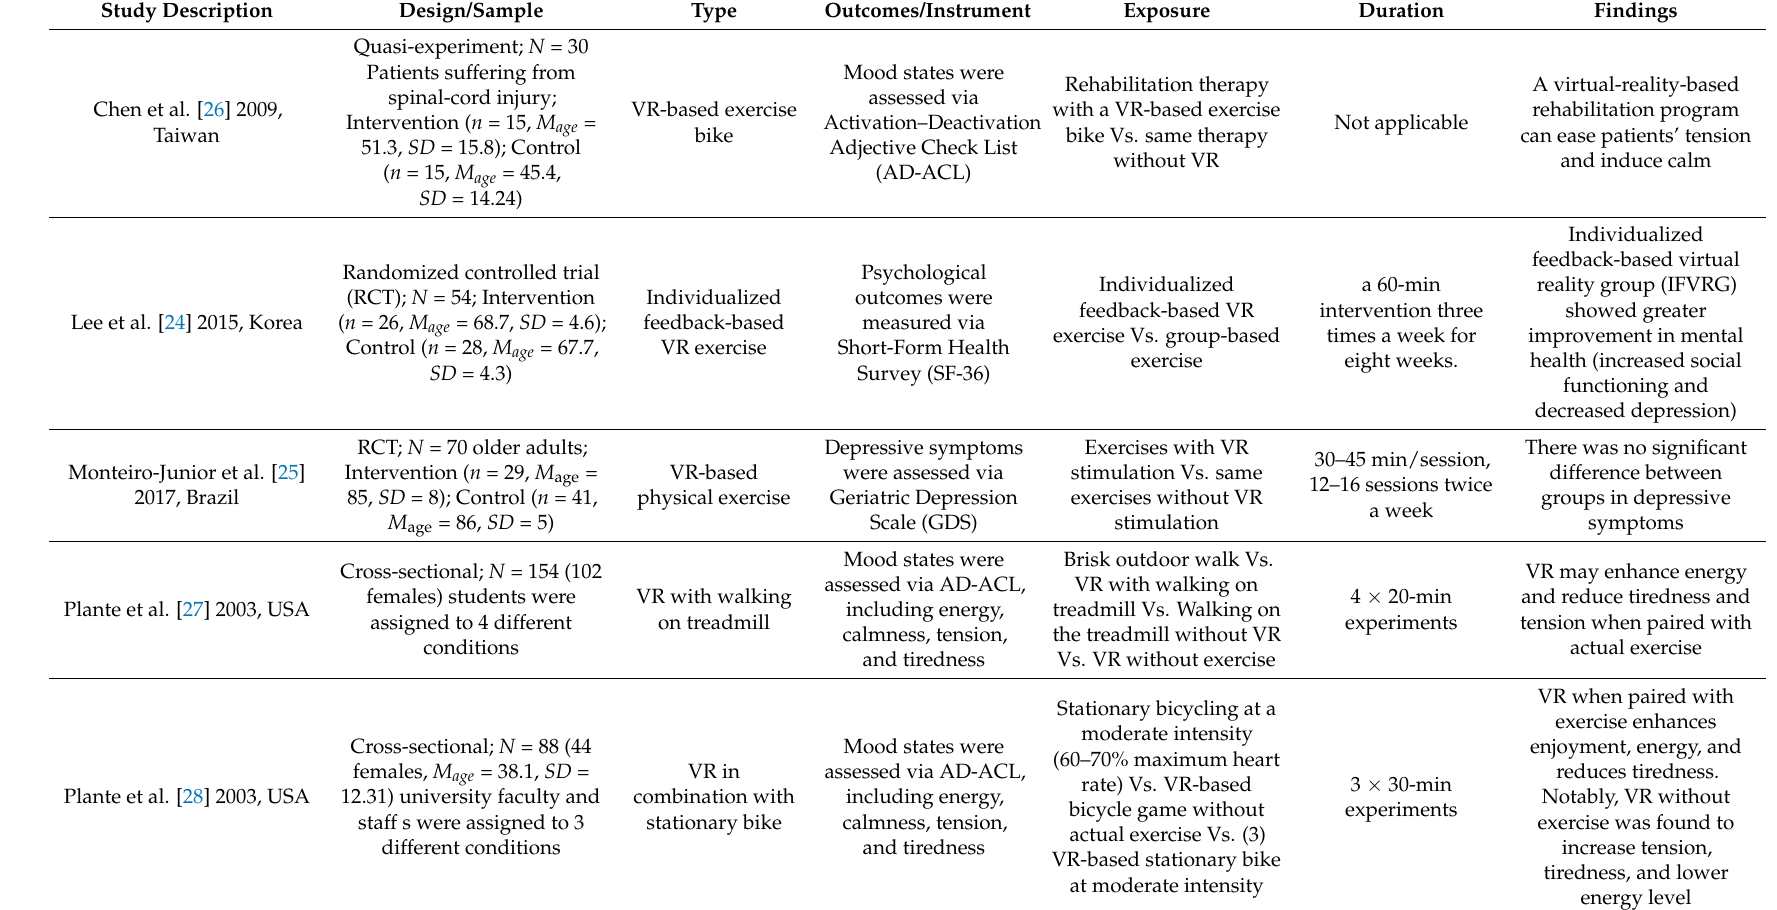
Table 2. Descriptive Characteristics of Included